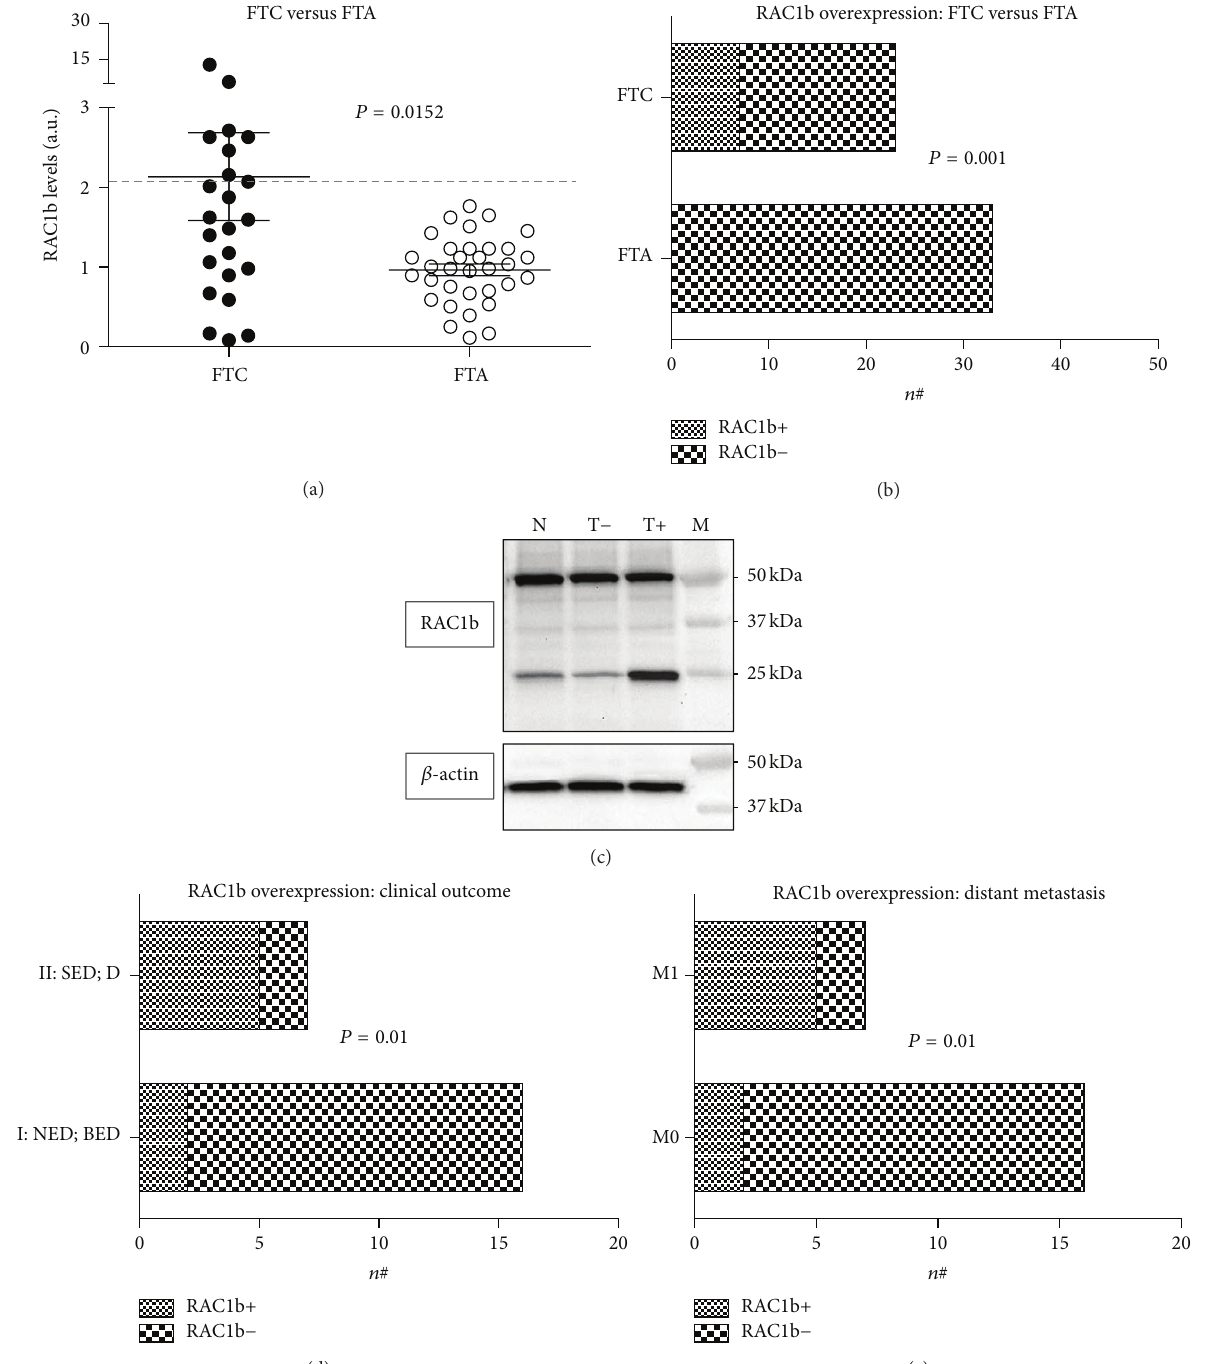
Figure 1: RAC1b expression in follicular thyroid tumors. (a) Expression levels of RAC1b among FTCs ( 𝑛 = 23 ) and FTAs ( 𝑛 = 33 ). RAC1b expression levels, quantified by qRT-PCR, correspond to arbitrary units representing fold differences relative to the reference sample; the threshold value defining RAC1b overexpression was set at 2.133 (corresponding to the mean plus two standard deviations of RAC1b expression level in a set of normal thyroid tissue samples). (b) Comparative analysis of RAC1b overexpression (RAC1b+) between follicular thyroid carcinomas (FTC) and follicular thyroid adenomas (FTA). (c) Western blot analysis of RAC1b protein levels in normal thyroid (N) and RAC1b overexpressing (T+) and nonoverexpressing (T − ) tumors; protein molecular weight marker (M). (d) Association of RAC1b overexpression (RAC1b+) with clinical outcome (Group I: NED: no evidence of disease, BED: biochemical evidence of disease; Group II: SED: structural evidence of disease, D: death due to disease). (e) Association of RAC1b overexpression (RAC1b+) with the presence (M1) or absence (M0) of distant